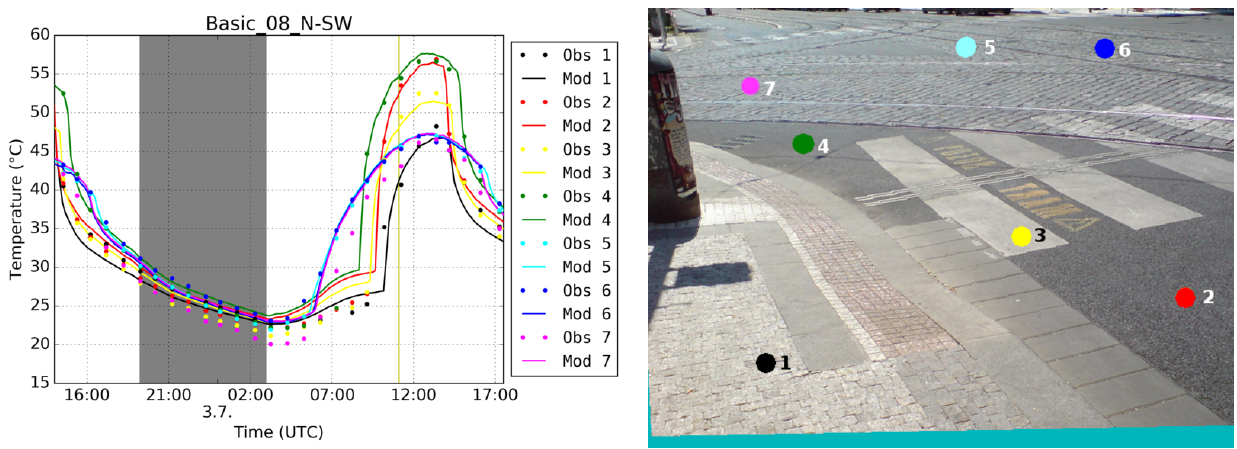
Figure 13. As for Fig. 9 for location 8 (50.10340 ◦ N, 14.45007 ◦ E) – view of the ground on the crossroads.